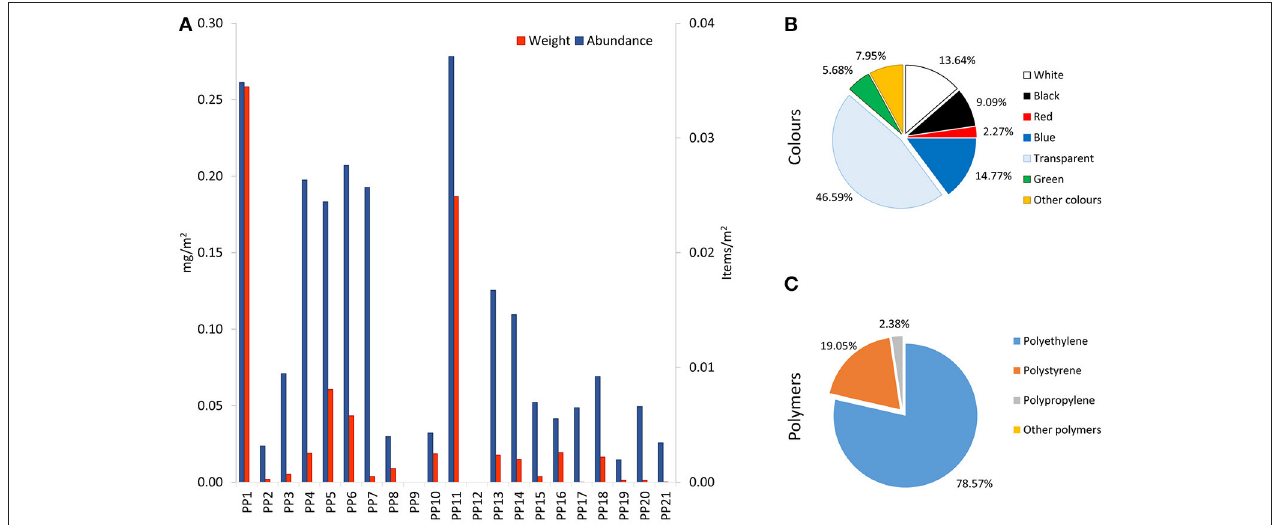
FIGURE 2 | Mesoplastic abundance and characterization in the Pelagos Sanctuary. (A) Mesoplastic abundance (items/m 2 ) and weight (mg/m 2 ) in the different sampling sites; (B) mesoplastic color; (C) mesoplastic polymers.